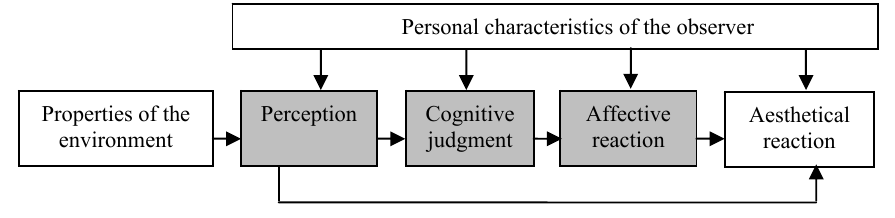
Figure 7: Model of the aesthetical reaction